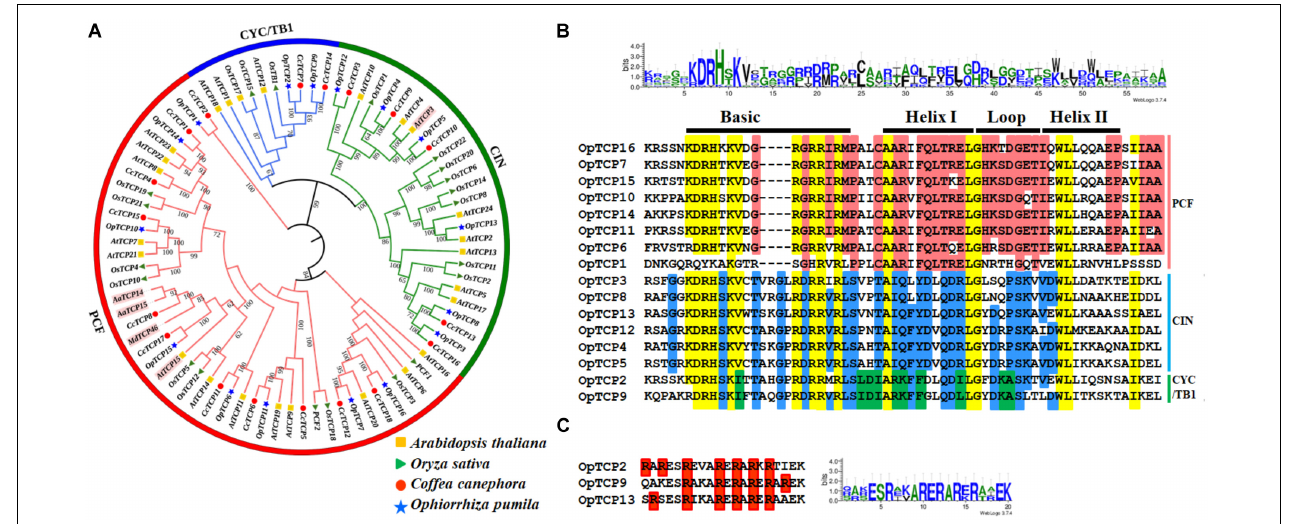
FIGURE 2 | Identification of TCP transcription factor genes in O. pumila . (A) Phylogenetic analysis of TCP proteins using the un-rooted Neighbor-Joining (NJ) method with 1,000 bootstrap replicates. Five TCP genes involved in special secondary metabolism are marked with pink shades. (B) The conserved TCP domains analysis using WebLogo and multiple sequence alignments by ClustalW. Each letter represents one amino acid, and the left column corresponds to the name of the gene. The yellow region indicates the highly conserved residues of the OpTCP family members, and the red region indicates residues conserved only in the class I subfamily. The blue region indicates residues conserved in the Class II subfamily. Green indicates the residues conserved in the CYC/TB1 class of proteins. The top black bar represents the conserved domain in TCP proteins. (C) The R domain in Class II members of the OpTCP gene family. TCP, teosinte branched 1/cycloidea/proliferating cell factors 1/2; OpTCP, O. pumila